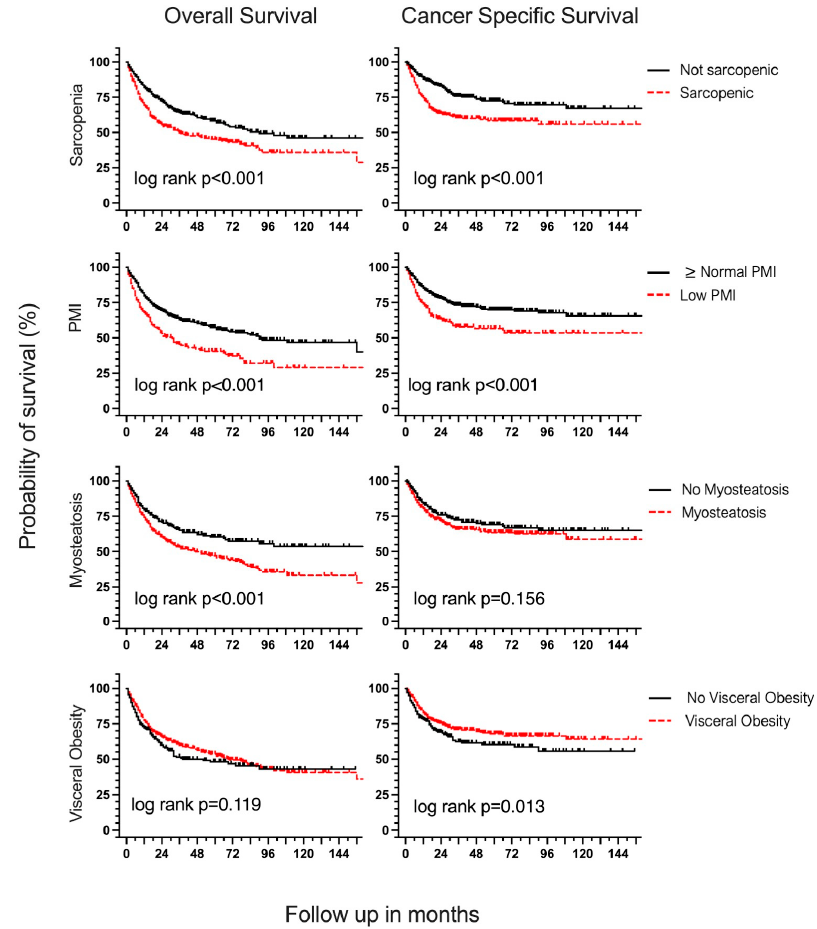
Figure 3. Illustration of Kaplan–Meier overall survival curves of body composition parameters for overall and cancer ‐ specific survival. Top to bottom: Sarcopenia (Martin), Low PMI, Myosteatosis (Martin), SFI (subcutaneous fat index), VFI (visceral fat index), visceral obesity. Table 3. Univariate Cox ‐ regression analysis for overall survival and cancer ‐ specific survival in the 657 radical cystectomy patients.